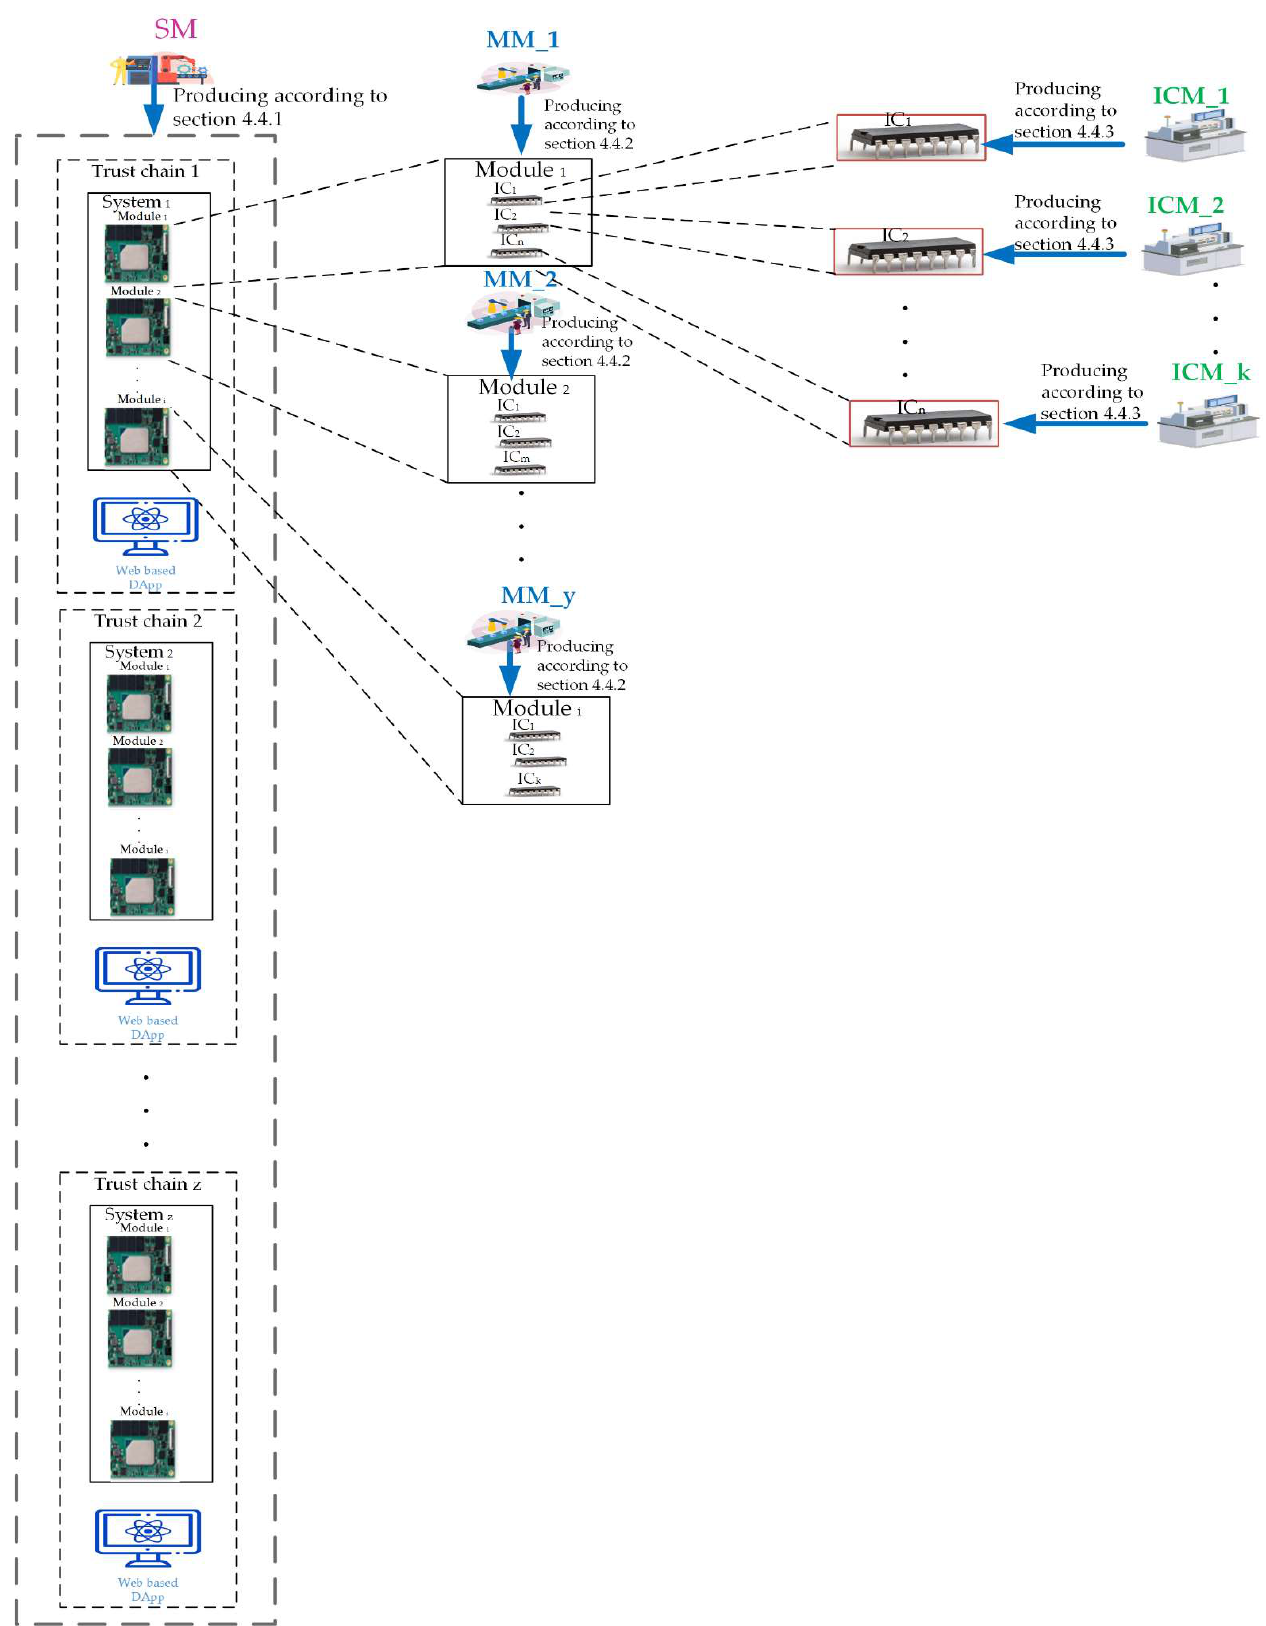
Figure 2. The architecture of this framework.